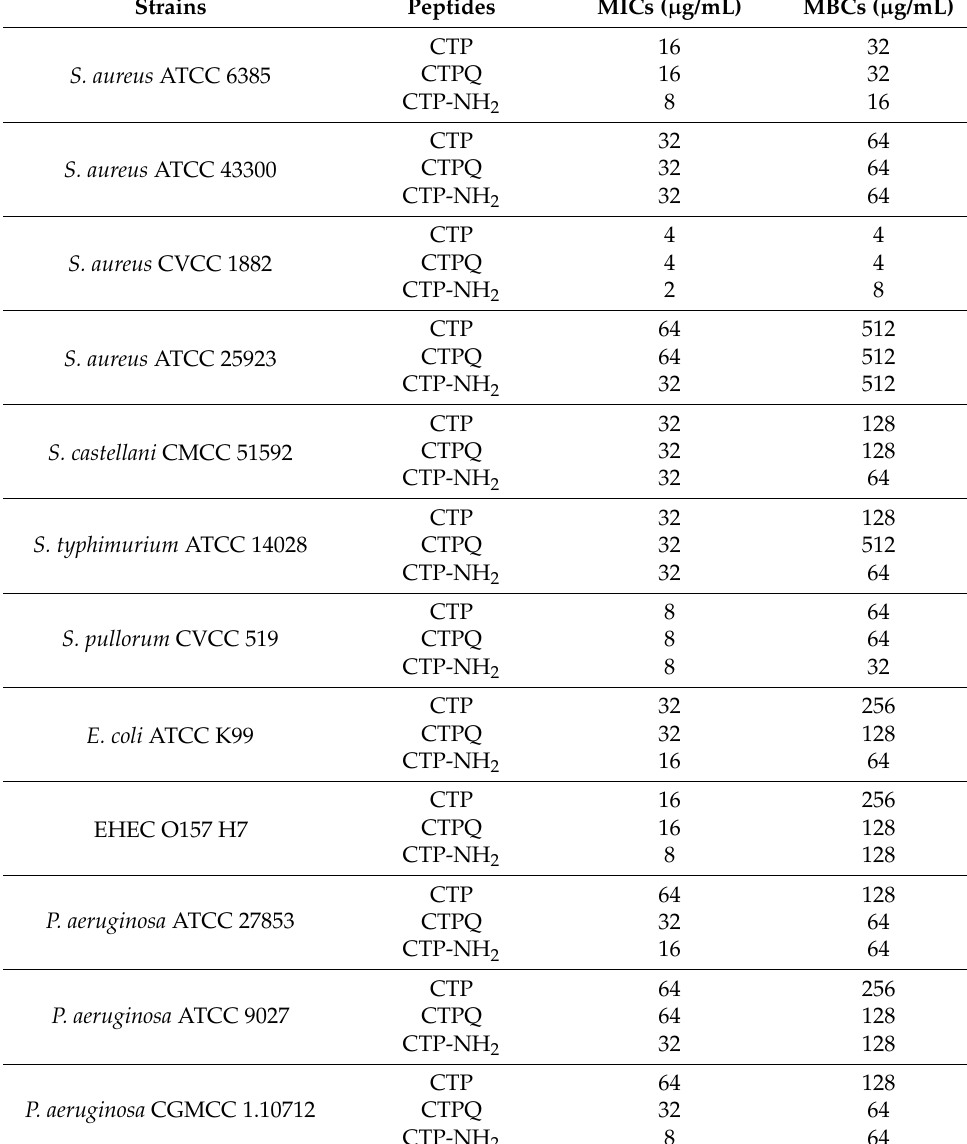
Table 2. MICs and MBCs of CTPs on different